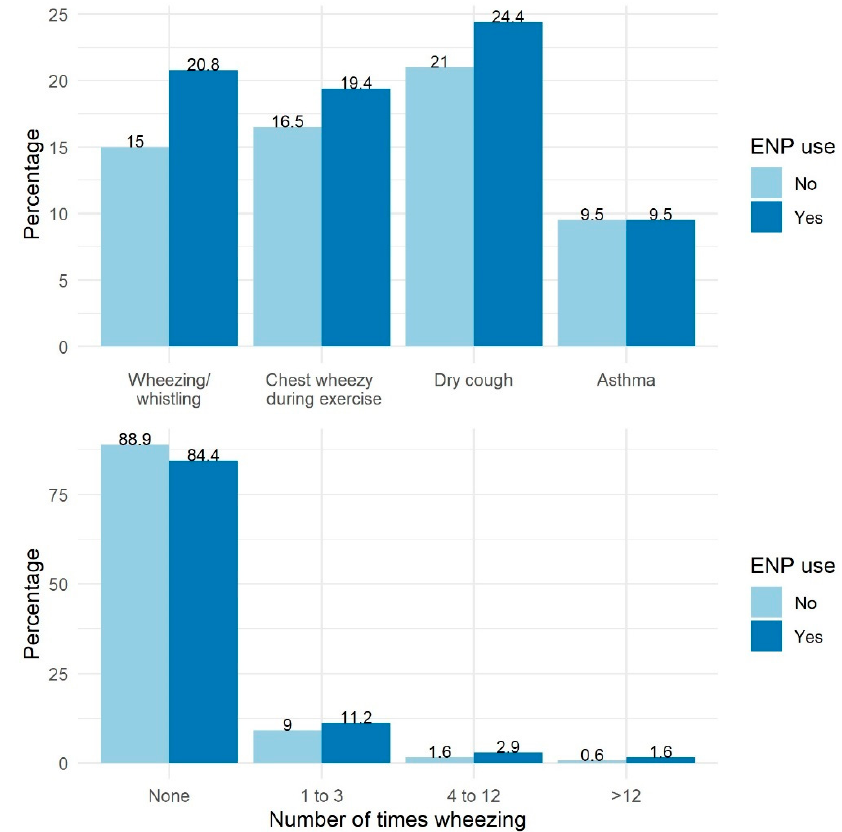
Figure 1. Respiratory outcomes (%) with and without electronic nicotine product (ENP) use in the past 12 months. Table 2. Unadjusted and adjusted association between electronic nicotine product use in past 12 month and respiratory outcomes ( n = 9769).